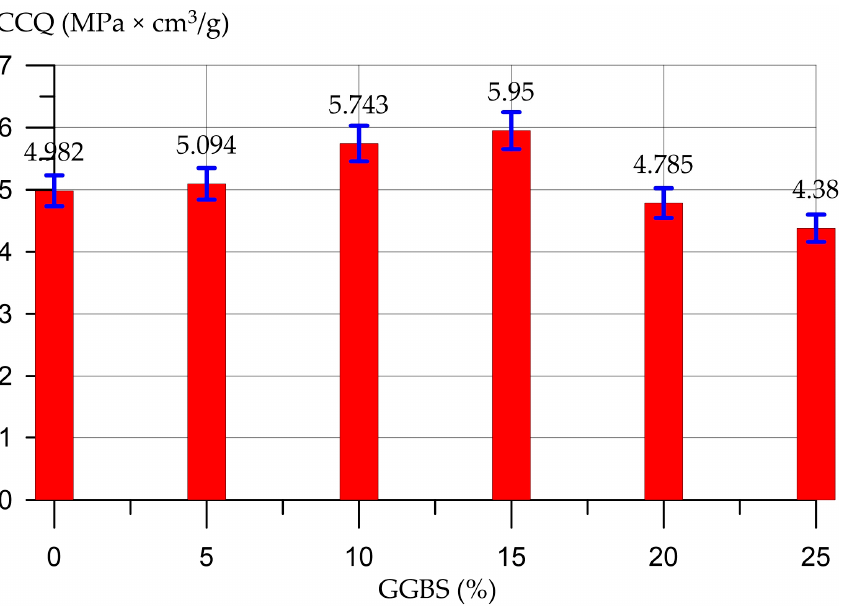
Figure 10. CCQ values of non-autoclaved aerated concrete modified with different GGBS content.